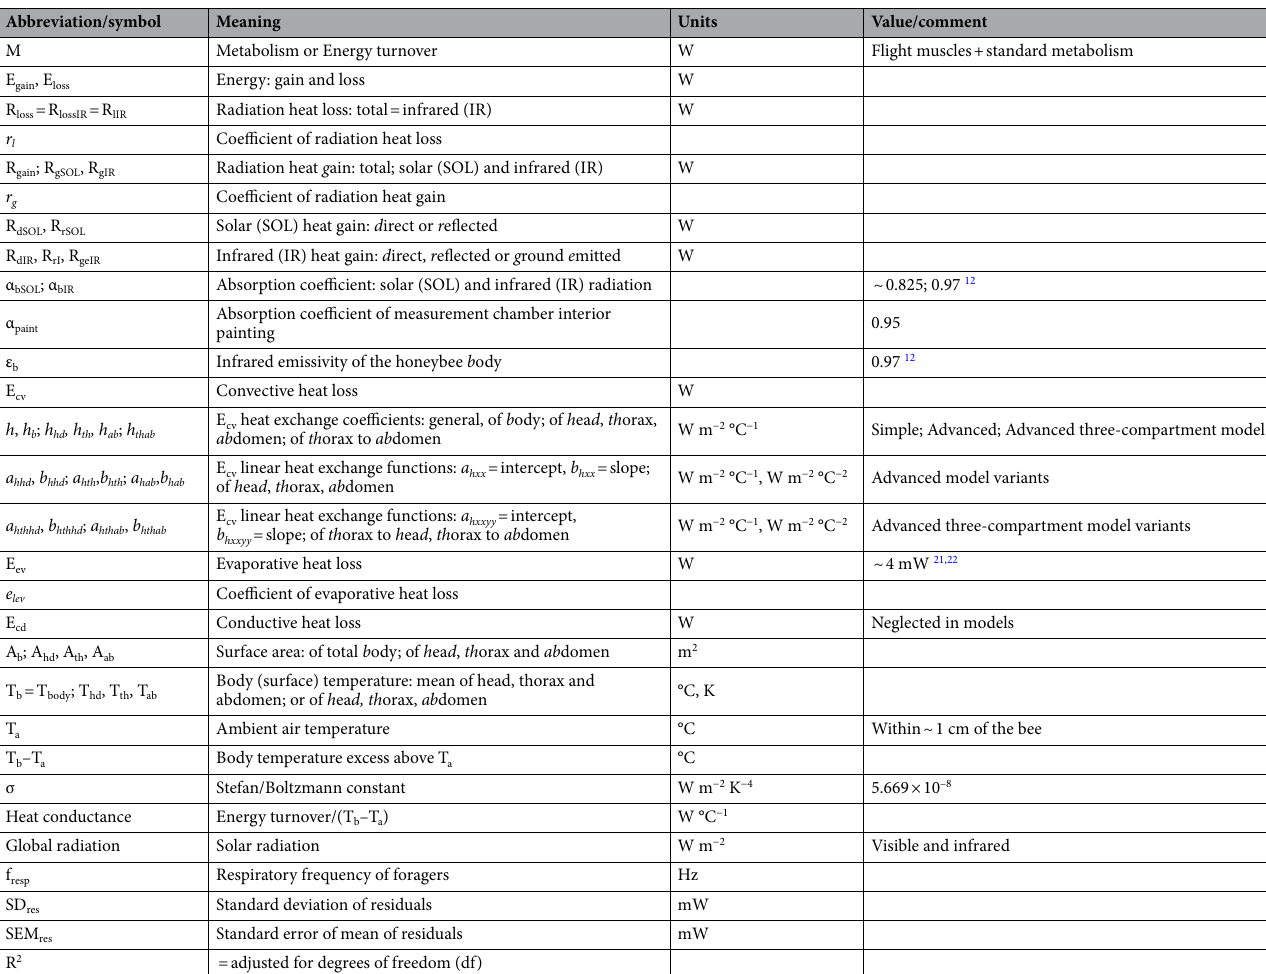
Table 1. Abbreviations or symbols used in formulas and text. Iteratively calculated coefficients are written in italics (left